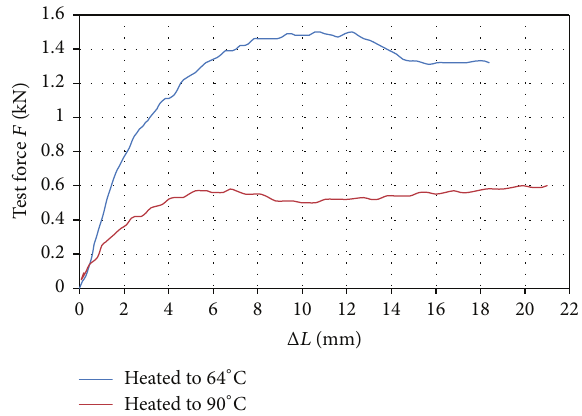
Figure 6: Force-elongation diagrams at different heating tempera- tures.